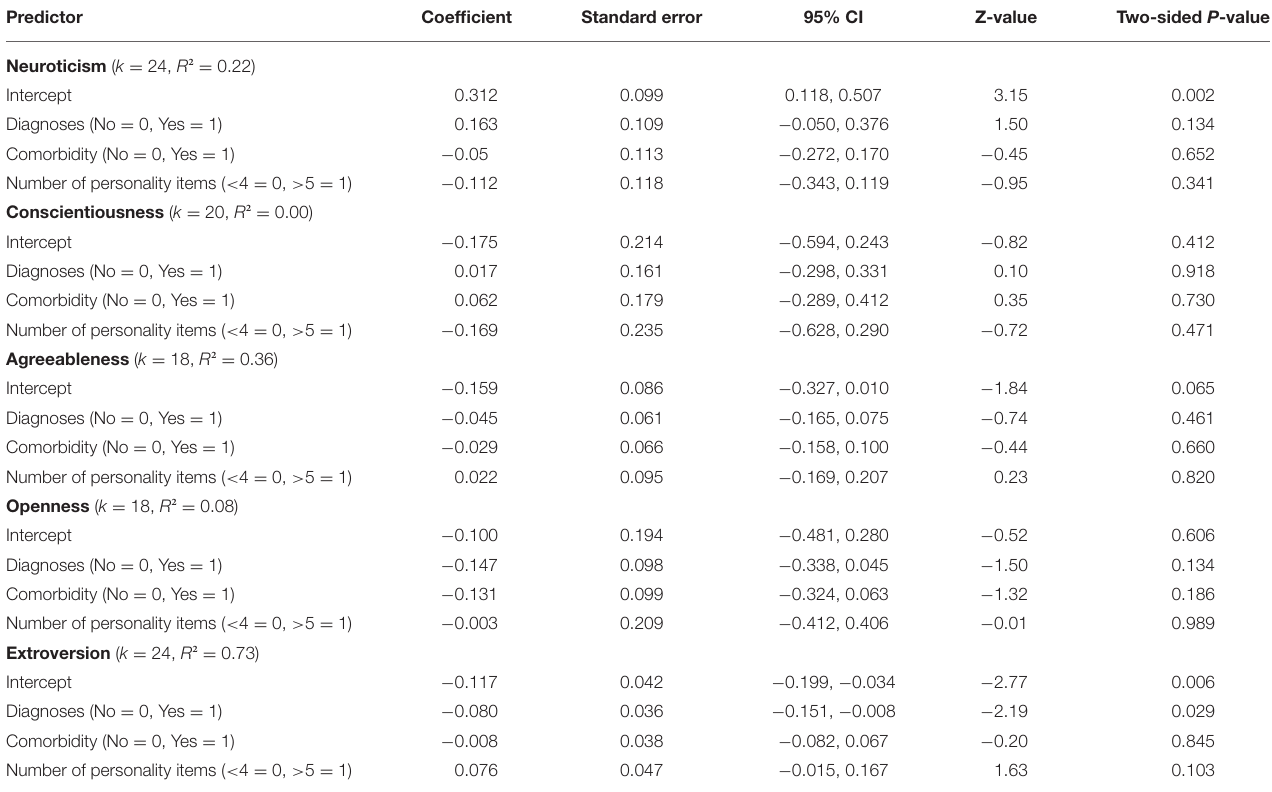
TABLE 3 | Meta-regression analysis summary for diagnosis, comorbidity, and number of personality items predicting the overall correlation effect size. Predictor Coefficient Standard error 95% CI Z-value Two-sided P -value Neuroticism ( k = 24, R ² =